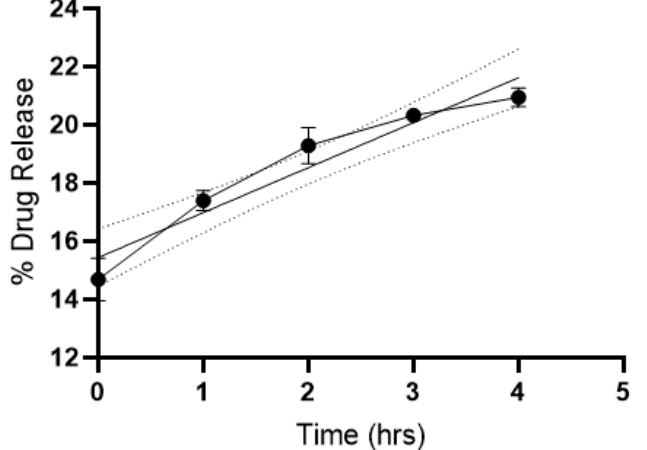
Figure 8. Release of TMZ in vitro from SLNP-TMZ at different time intervals (0–4 h) at pH = 7.0. The experiment was conducted in triplicateand the dotted lines represent the 95% confidence interval for the mean values, the data were plotted as mean ±